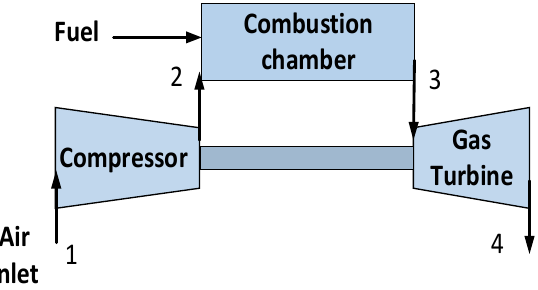
Figure 1. Main components of gas turbine unit.